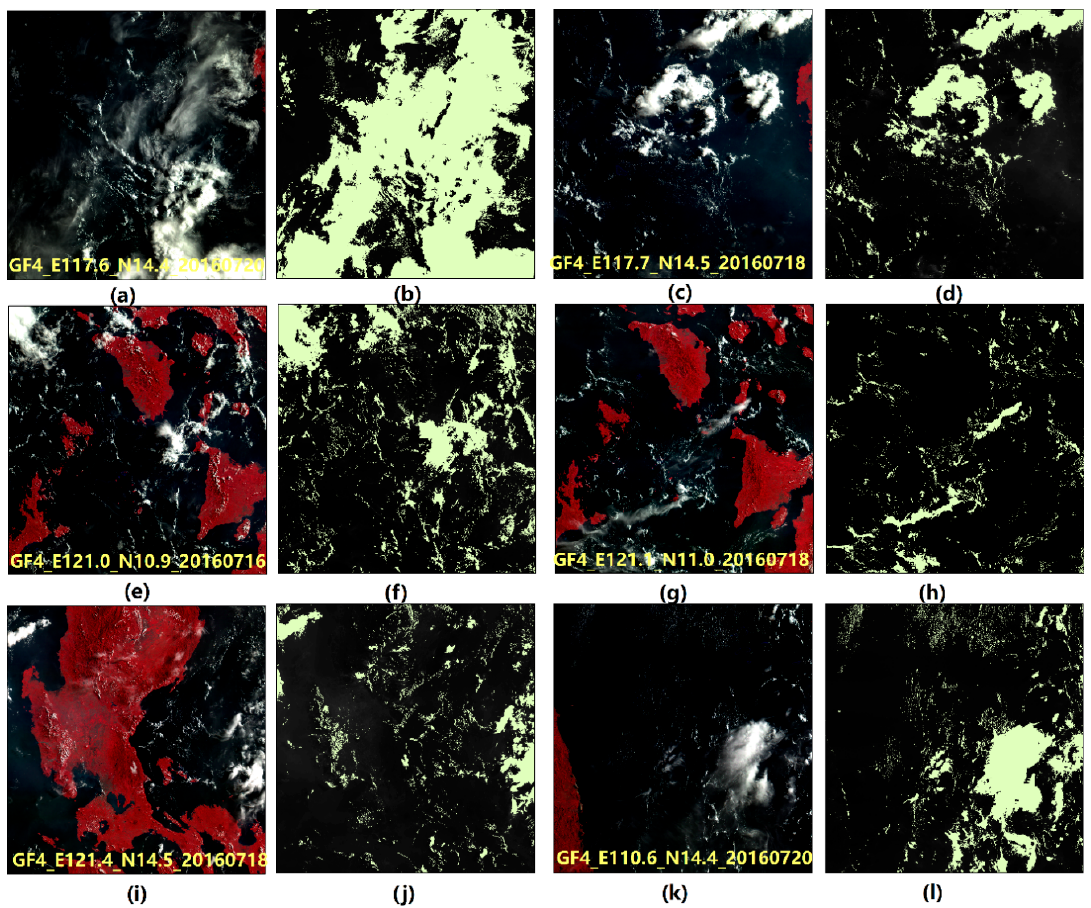
Figure 3. Cloud detection results for GF-4 PMS scenes in the coastal area . False-color composite images with bands 5, 4, and 3, denoting the near-infrared, red, and green bands, respectively, are depicted in ( a ), ( c ), ( e ), ( i ), and ( k ), while their detection results are presented in ( b ), ( d ), ( f ), ( h ), ( j ), and ( l ), respectively. The cloud detection results in black represent the cloud-free region, while the results in white color represent the cloudy region. The data acquisition dates are listed in Table 2 .